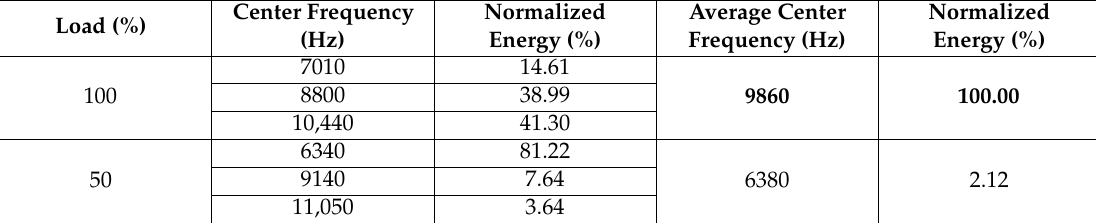
Table 6. Average Center Frequency and Normalized Energy of 100% and 50%